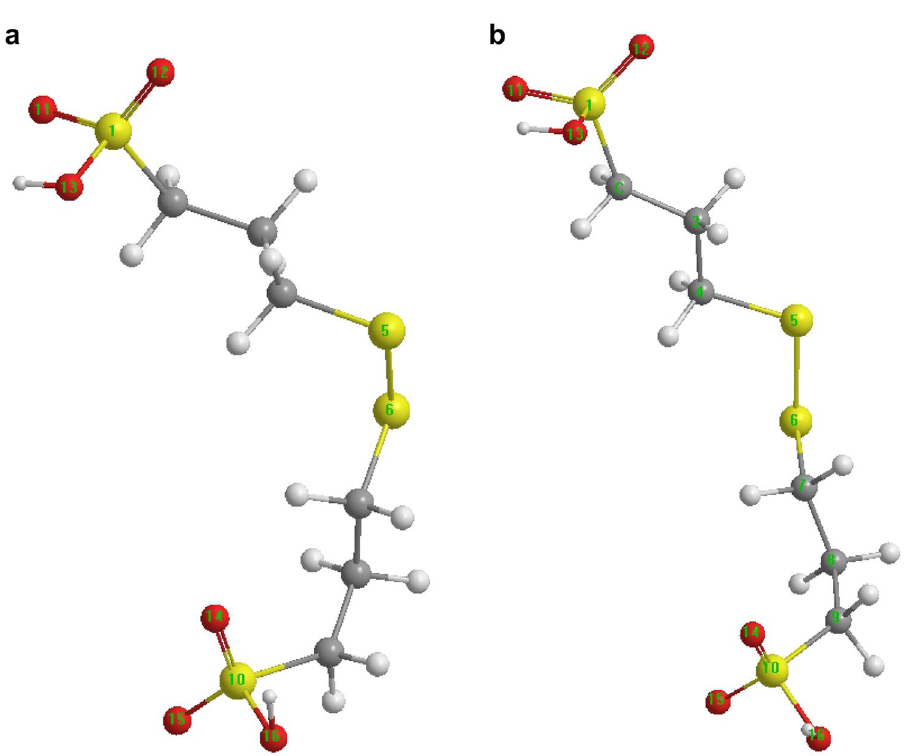
Figure 6. Molecular configuration of SPS from MD simulations. ( a ) Initial and ( b ) equilibrium structures ( https:// www. 3ds. com/ produ cts- servi ces/ biovia/ material studio